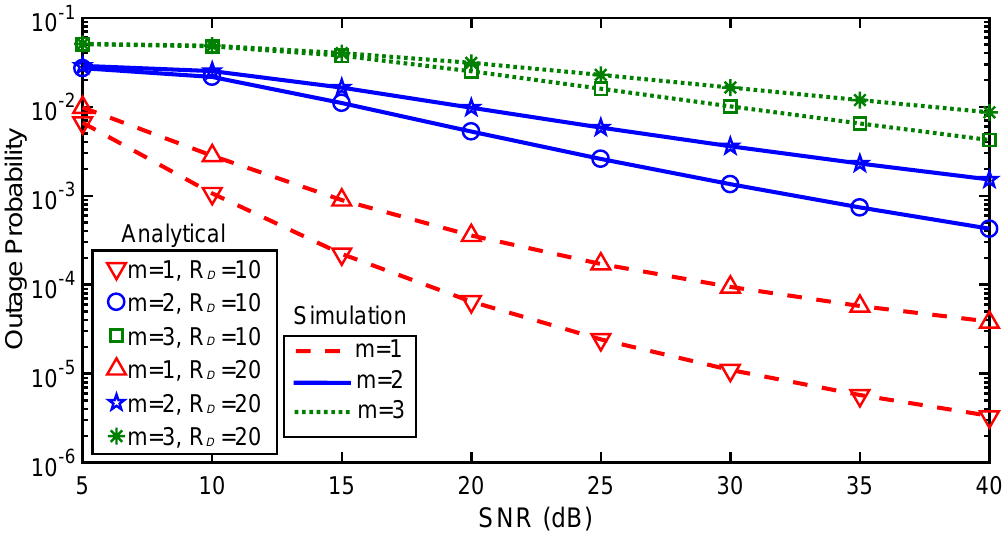
Figure 2. Impact of R D on outage